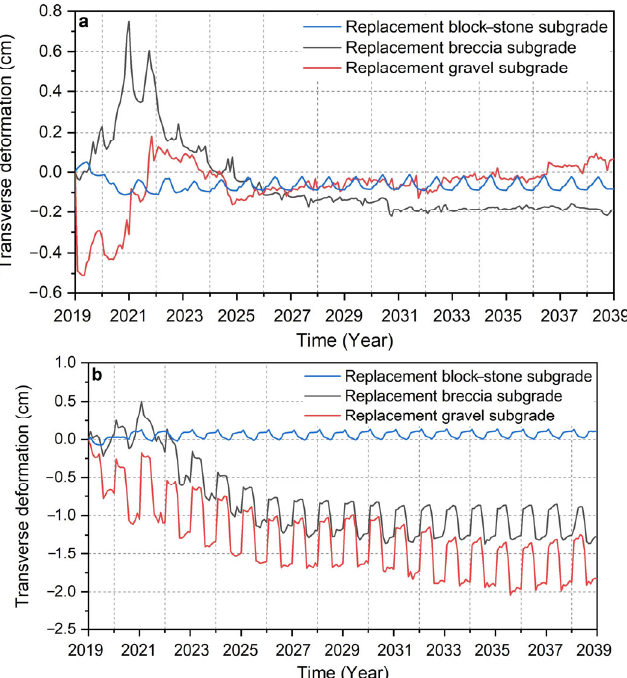
Figure 18. Transverse deformation curves at the road centerline and the shoulder of the three subgrade structures in Case 1: ( a ) at the road centerline and ( b ) at the shoulder.